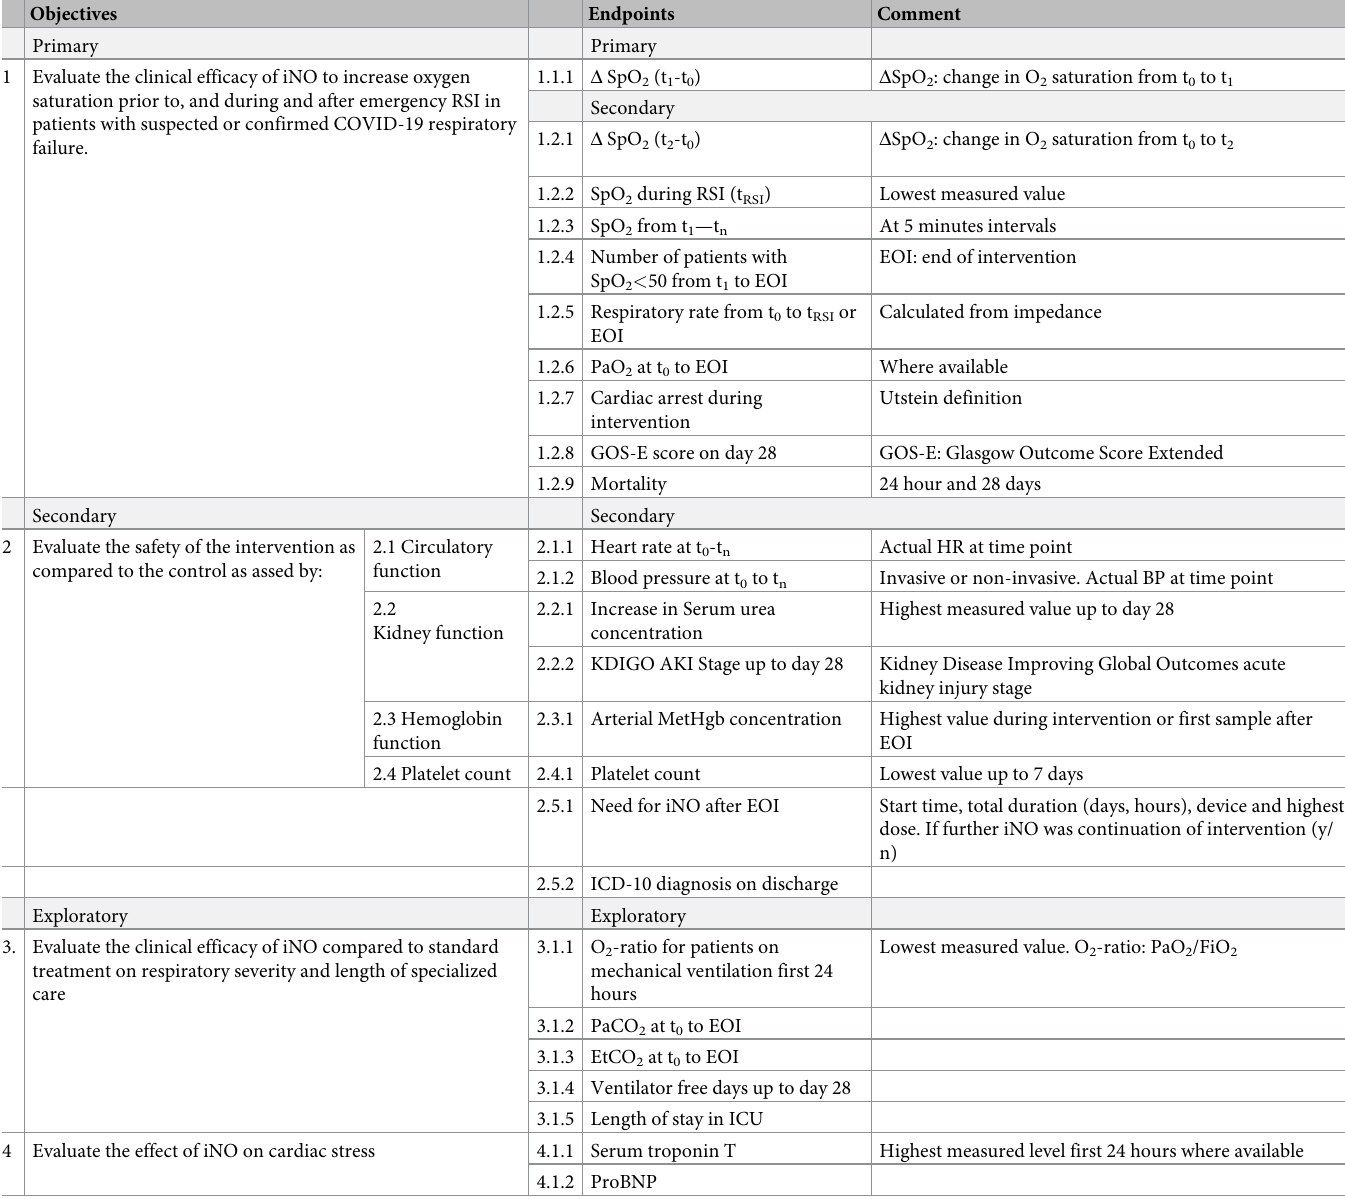
Table 1. Study objectives and related